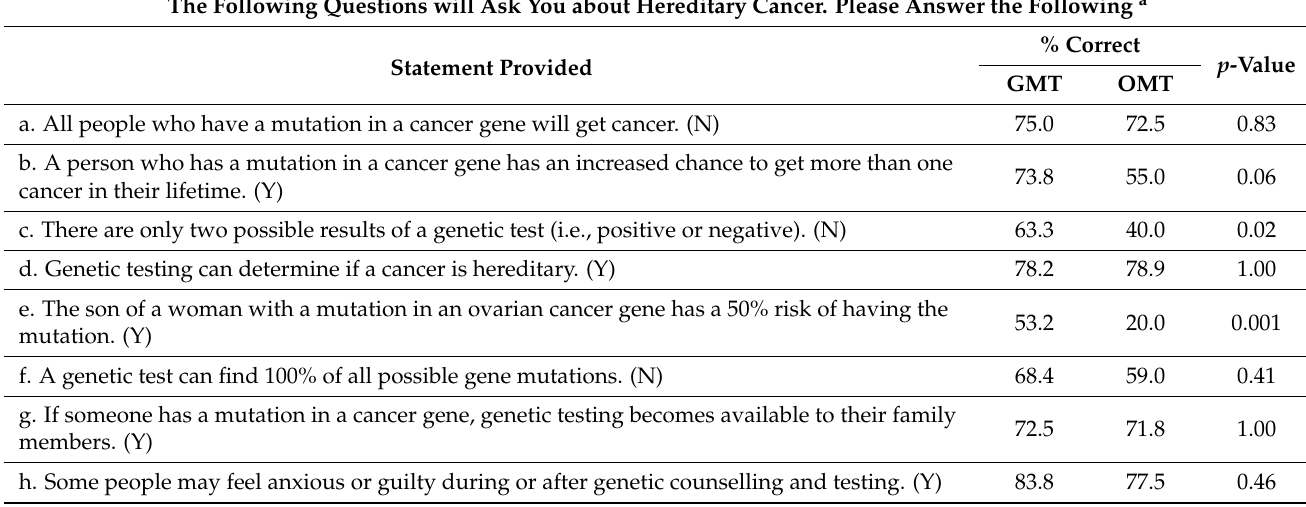
Table 4. Responses to genetic testing knowledge